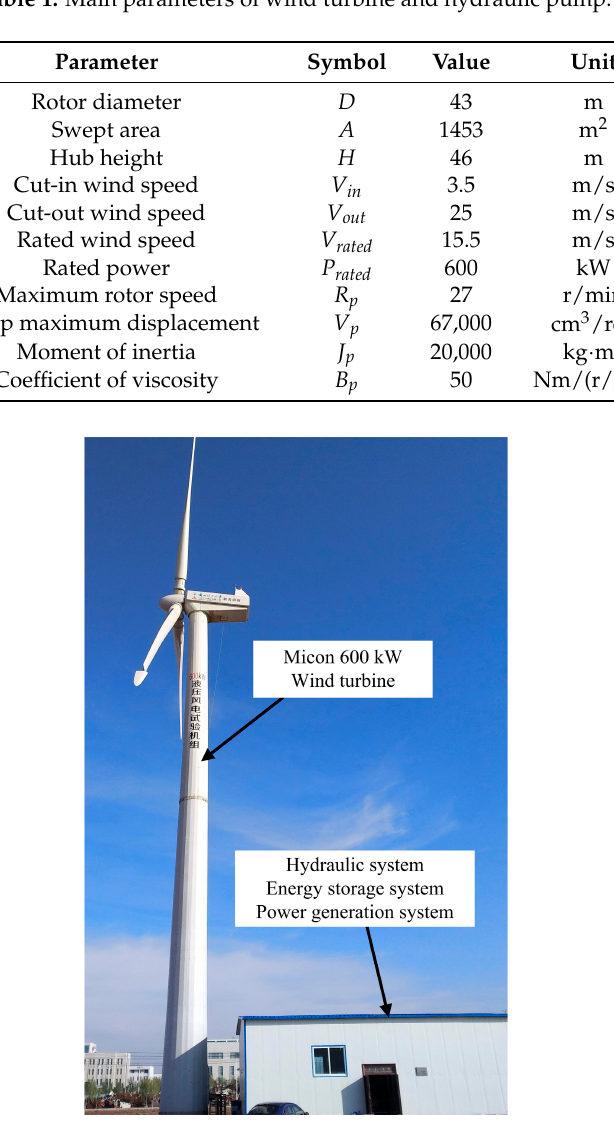
Figure 7. The Micon 600 kW wind turbine experimental platform.